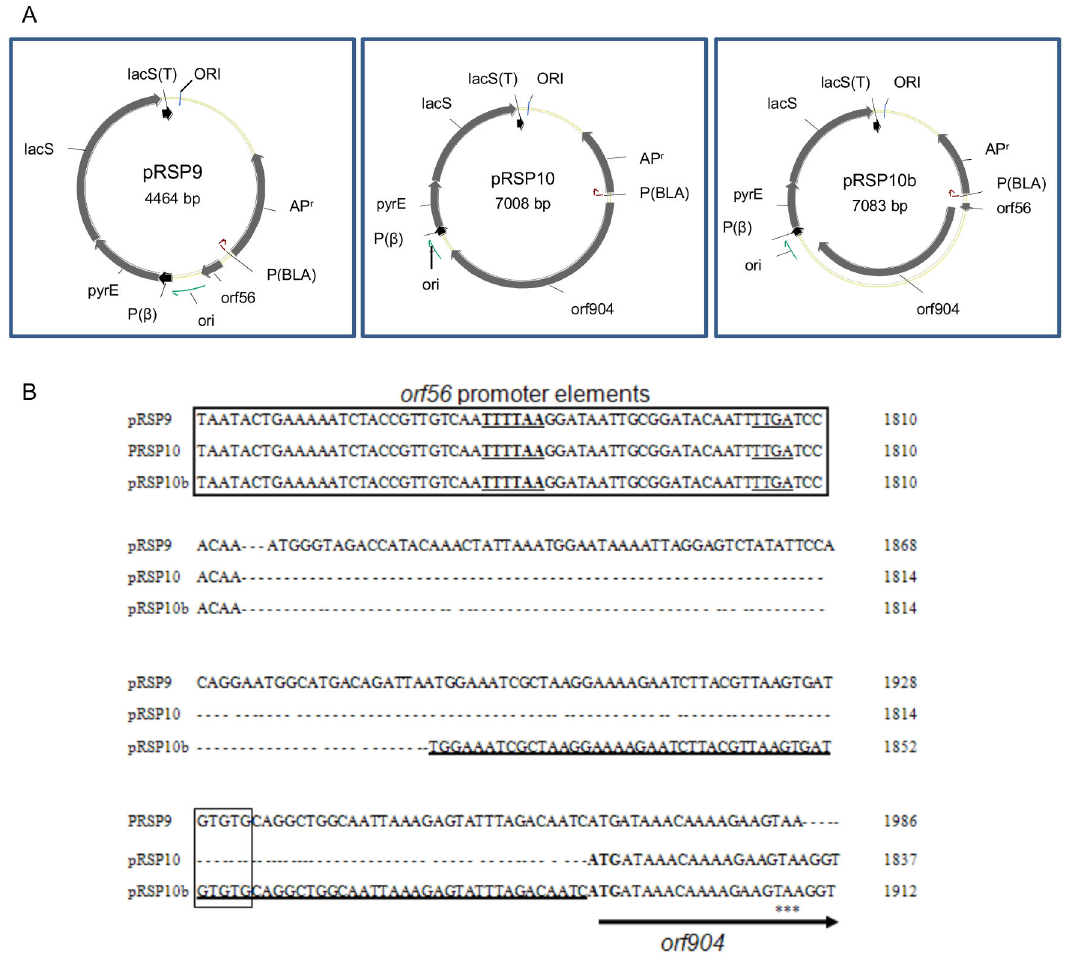
Figure 5. In-trans complementation of orf56 and orf904 deletion mutants of pRSP1. (A) Deletion mutants of pRSP1 generated by deleting orf904 (pRSP9) and orf56 (pRSP10/pRSP10b) from pRSP1; pRSP10 contained a complete orf904 under the control of orf56 transcription and translation elements, while pRSP10b contained an additional 75-bp at the 5’ of orf904 start codon. Each plasmid contains pUC19 and pRN1 origins of replication, the pyrE-lacS cassette transcribed by the S. solfataricus thsB promoter [P(β)] and lacS terminator element [lacS(T)], and AP r gene (ampicillin resistance). (B) Cis -acting elements at the 5’ of orf56 and orf904 in each plasmid. Transcription of orf904 in pRSP10 and pRSP10b is controlled by of orf56 promoter elements (big bold box) with putative TATA box A (bold single underline) and TATA box B (single underline). The 75-bp element 5’of orf904 in pRSP10b (bold underline) contains a putative RBS (small box). The start of orf904 is bolded, and the stop of orf56 is represented by (***). doi: 10.1371/journal.pone.0084664.g005 (Table 4). The pRSP9/pRSP10b transformants grew very poorly in liquid medium, making it challenging to recover plasmid DNA for further analysis. The reason for poor growth of the pRSP9/pRSP10b is not known but the transformation result was consistent after more than three attempts. In addition to the suggestion that some elements within the additional 75-bp sequence in pRSP10b might be important for plasmid function; the result from the pRSP9/pRSP10b transformation highlights the possibility of transforming S. acidocaldarius with more than one plasmid.